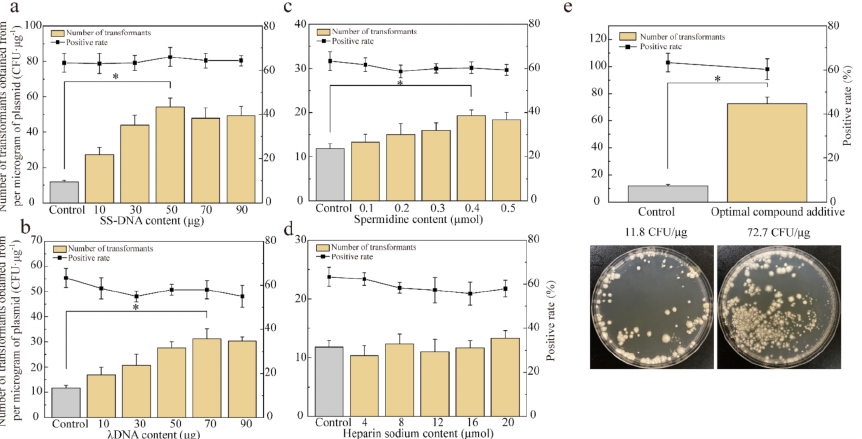
Figure 4. Effect of promoting factors on transformation efficiency. ( a ) SS-DNA; ( b ) λ DNA; ( c ) spermidine; and ( d ) heparin sodium. ( e ) Optimal compound additive (50 µ g SS-DNA con- tent, 70 µ g λ DNA, and 0.4 µ mol spermidine). Significance was calculated using the highest value in each group and control. * p <